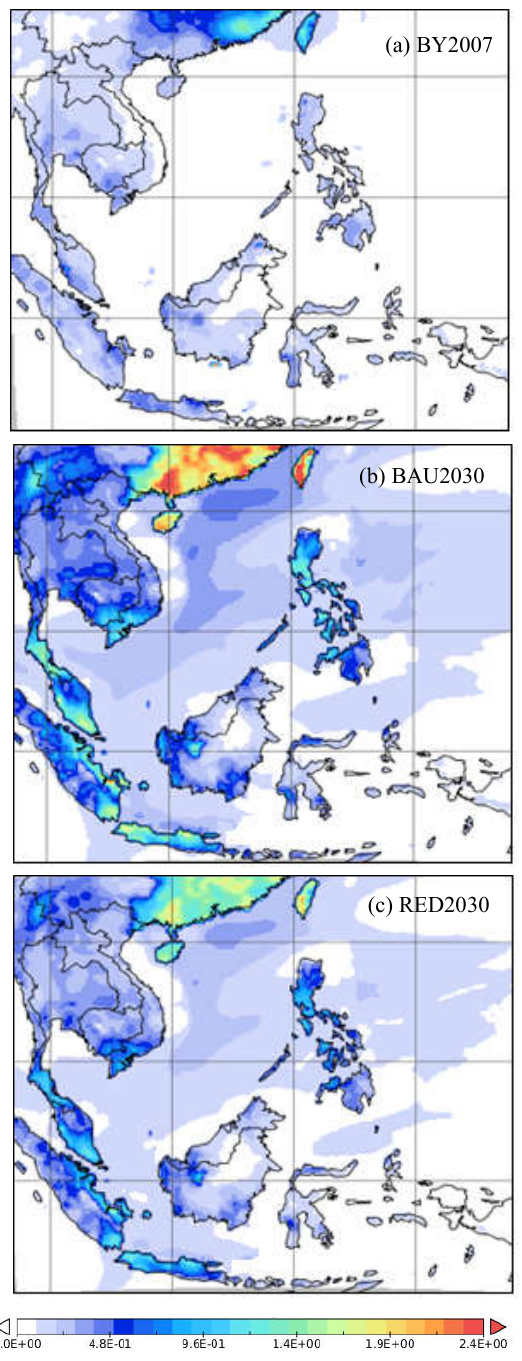
Figure 4. Spatial distribution of annual average BC DRF under BY2007, BAU2030 and RED2030